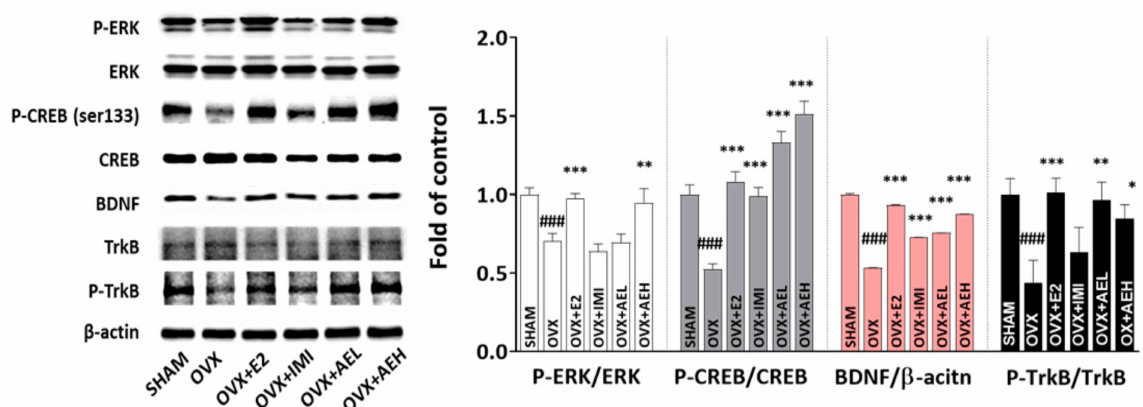
Figure 4. Immunoblots showing the hippocampal ERK–CREB–BDNF signaling-pathway-related protein expression levels of the OVX mice treated with AE (100 or 300 mg/kg/d, p.o.). Results are presented as mean ± SD. ### p < 0.001 vs. SHAM group; * p < 0.05, ** p < 0.01, *** p < 0.001 vs. OVX